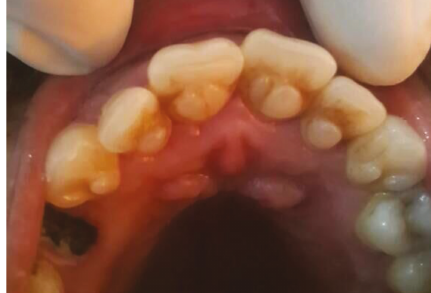
Figure 23: Case 5: talon cusps in all upper anterior teeth.